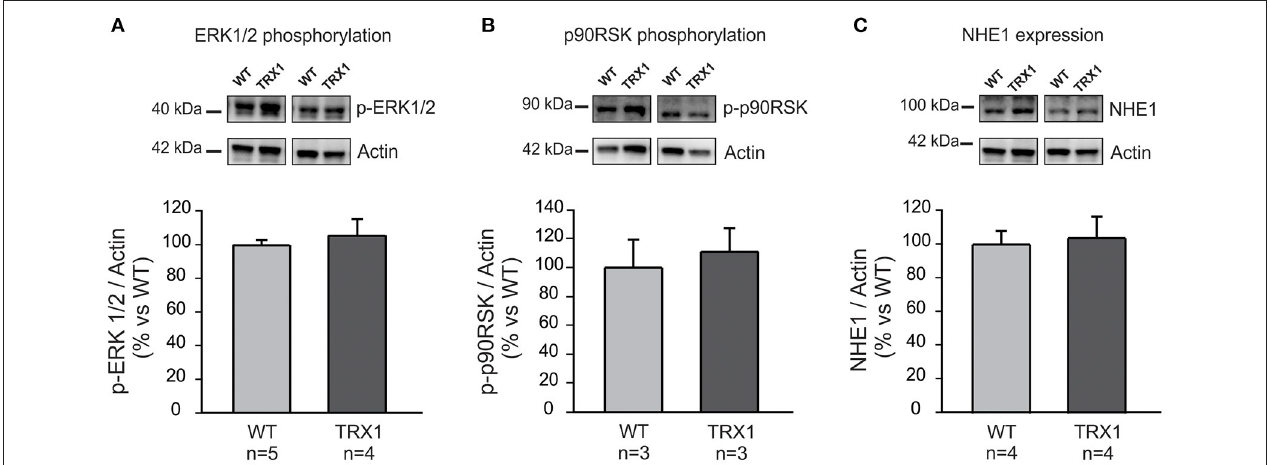
FIGURE 3 | ERK1/2, p90RSK phosphorylation, and NHE1 expression. Basal ERK1/2 (A) and p90RSK (B) phosphorylation, as well as NHE1 expression (C) were similar in both experimental groups. Original blots (top) and averaged data